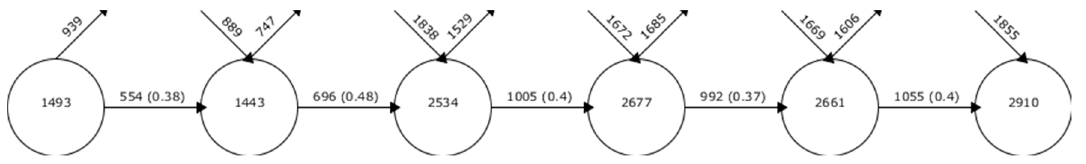
Figure 3. Continuity of keywords between contiguous intervals.